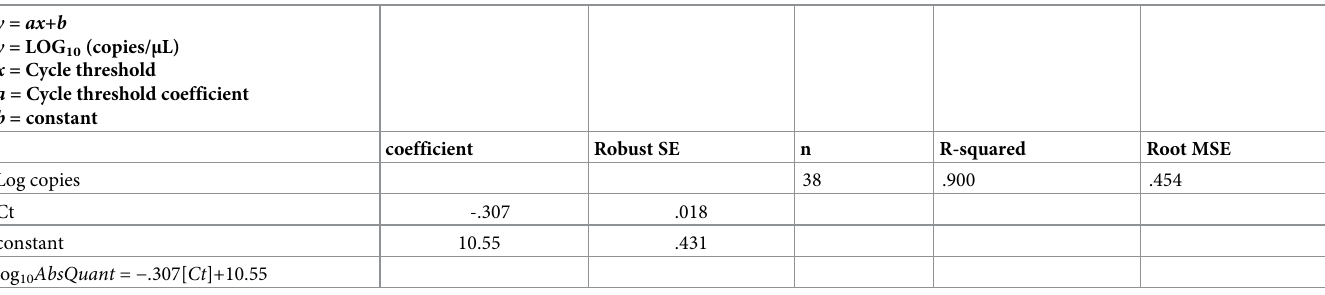
Table 1. Linear regression model including copies/ μ L as a dependant variable and cycle threshold (Ct) as a predictor factor. y = ax + b y = LOG 10 (copies/ μ